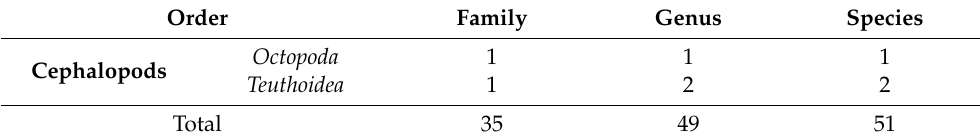
Table 1. Cont . Order Family Genus Species Octopoda Cephalopods Teuthoidea